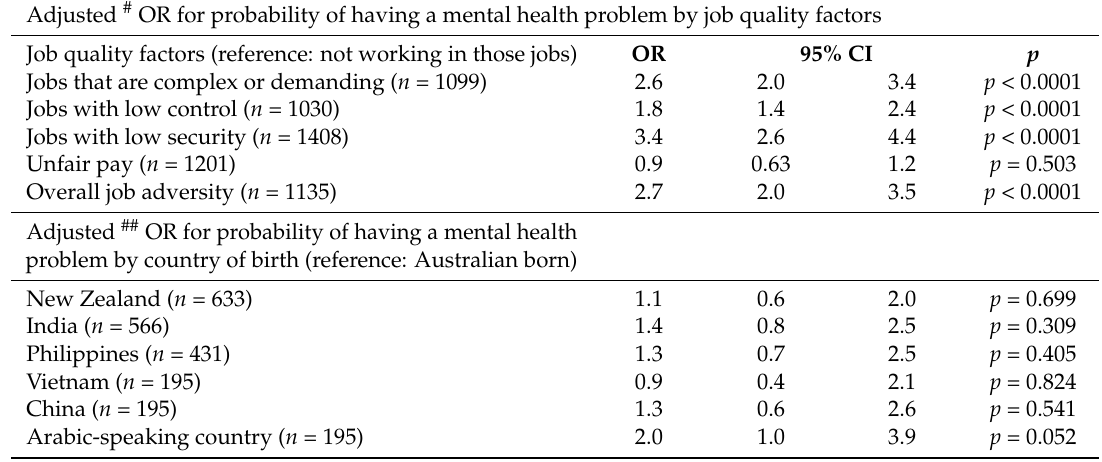
Table 3. Risk of having a mental health problem by psychosocial job quality factors and country of birth, Australian Migrant/Ethnic Minority Workers Exposure